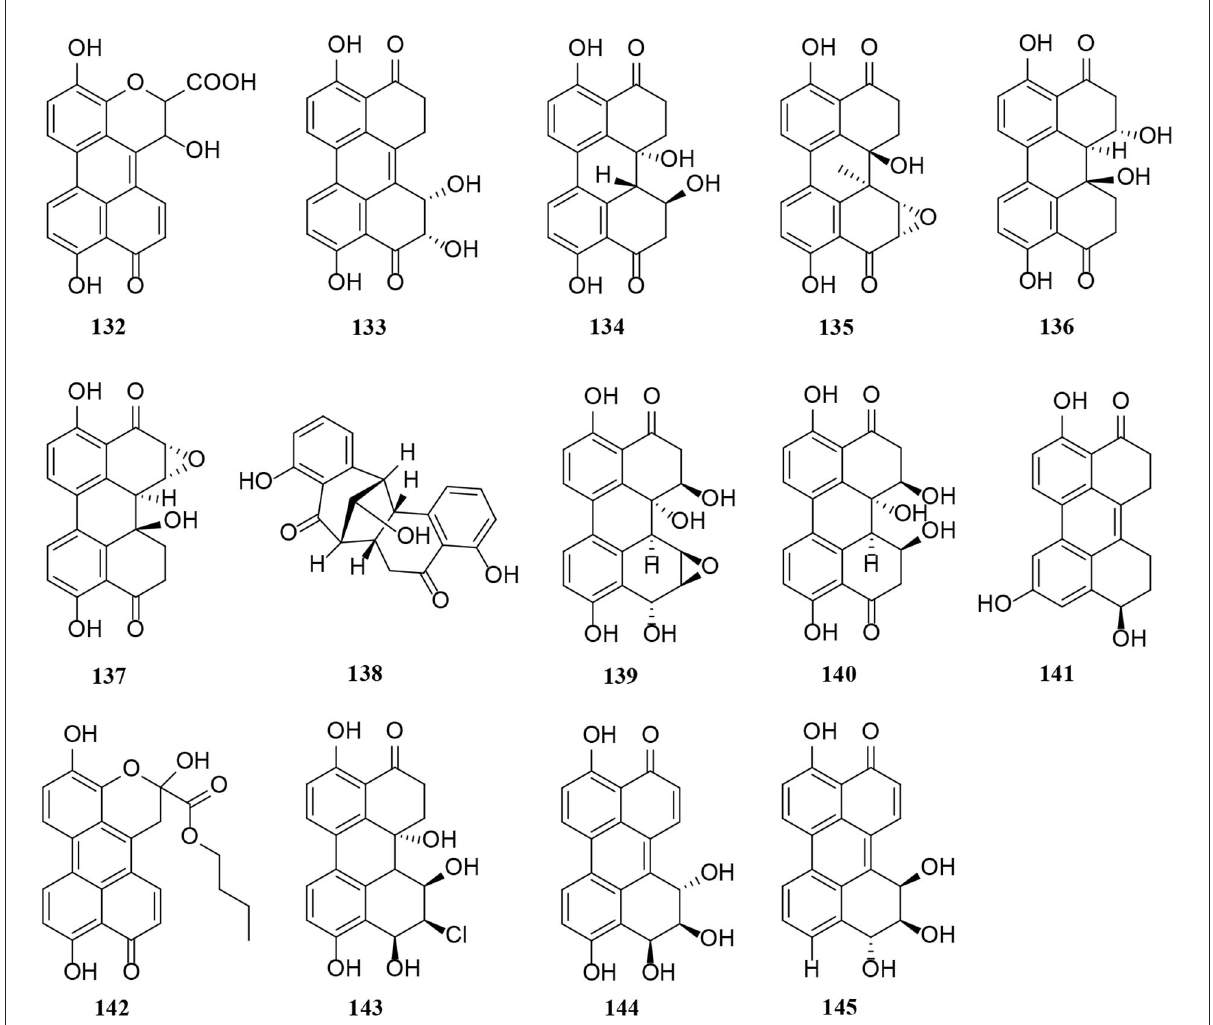
FIGURE8 Perylene quinone derivatives ( 132 – 145 ) from Alternaria